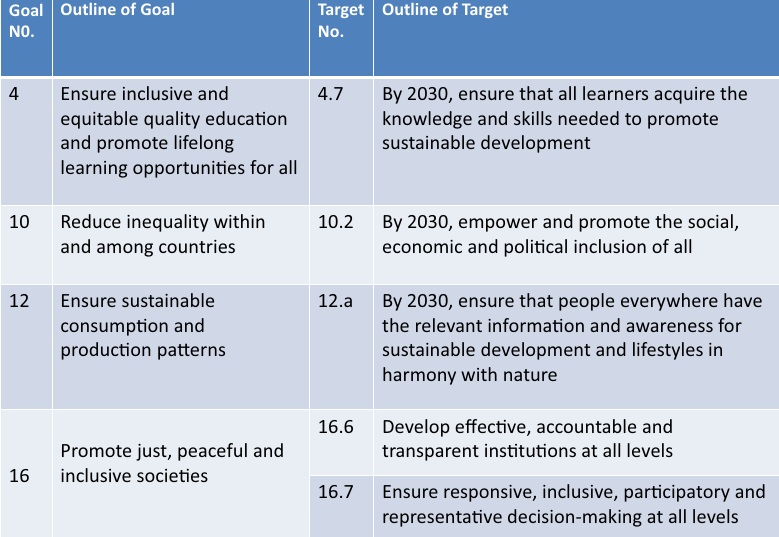
Fig. 5 Selected goals and targets on